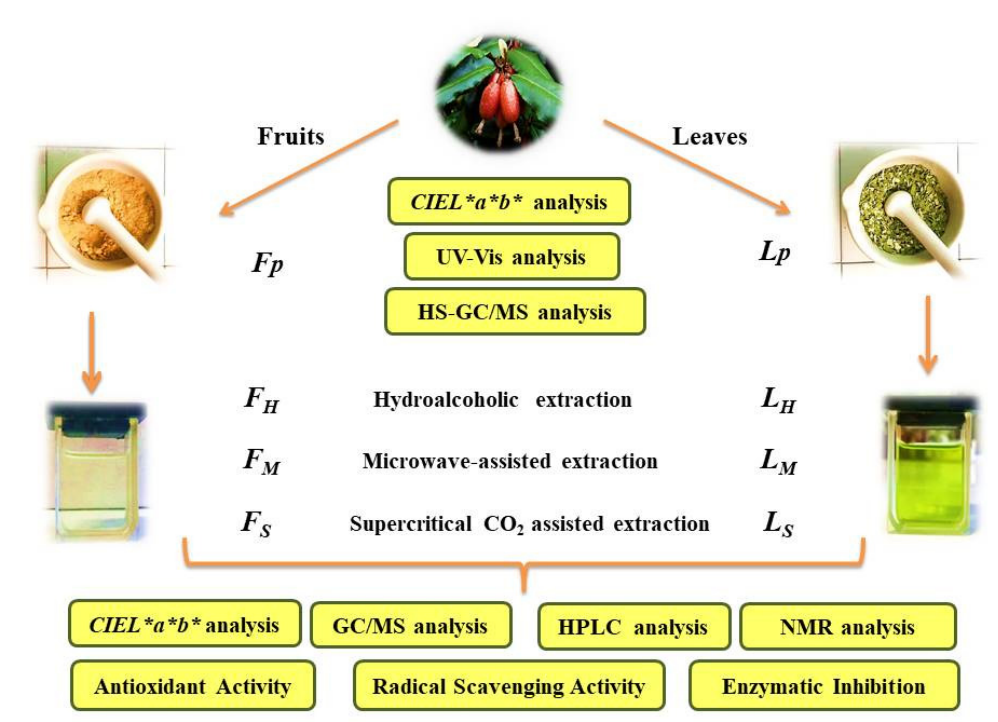
Figure 1. Flowchart of the adopted work-up.